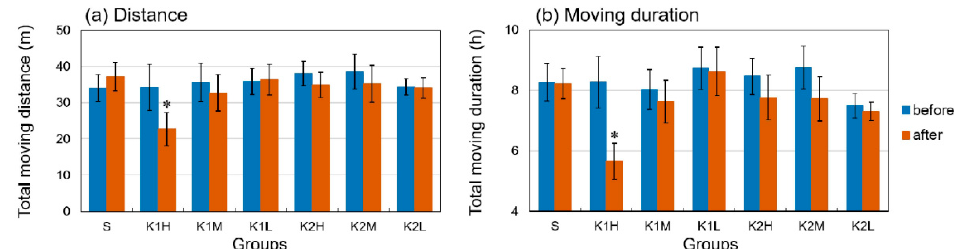
Figure 1. The total distance moved ( a ) and cumulative moving duration ( b ) before and after injection for each group. The data in the figure are total measured data for 12 h. Each error bar represents the standard error. S is the seawater control group, K1 and K2 are the neuropeptide treatment groups, and H/M/L represent high, medium, and low concentrations. *, significant difference within the group ( p < 0.05).